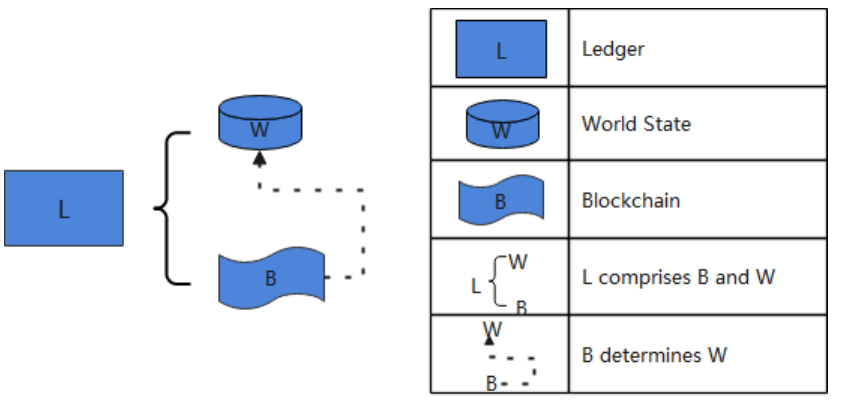
Figure 1. Fabric data storage structure.